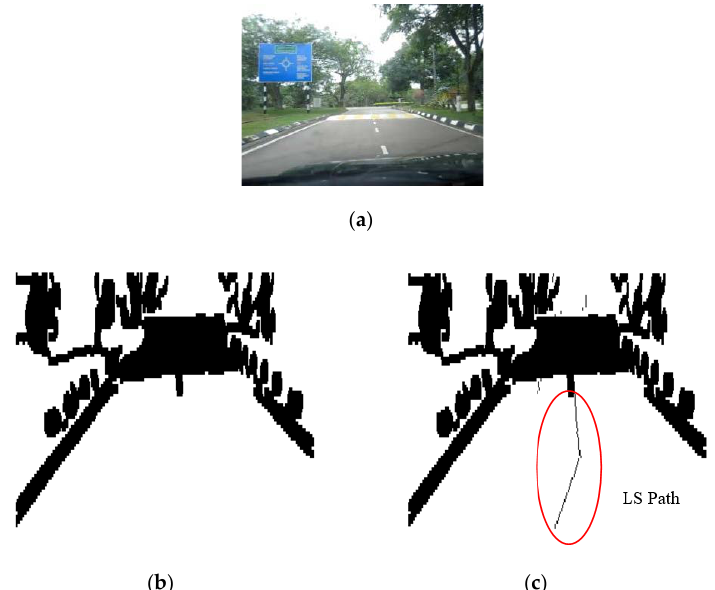
Figure 5. Image sequences processing where roundabout is detected using Laser Simulator: ( a ) original image in gray scale, ( b ) image after applying curbs and roundabout detection, ( c ) image after